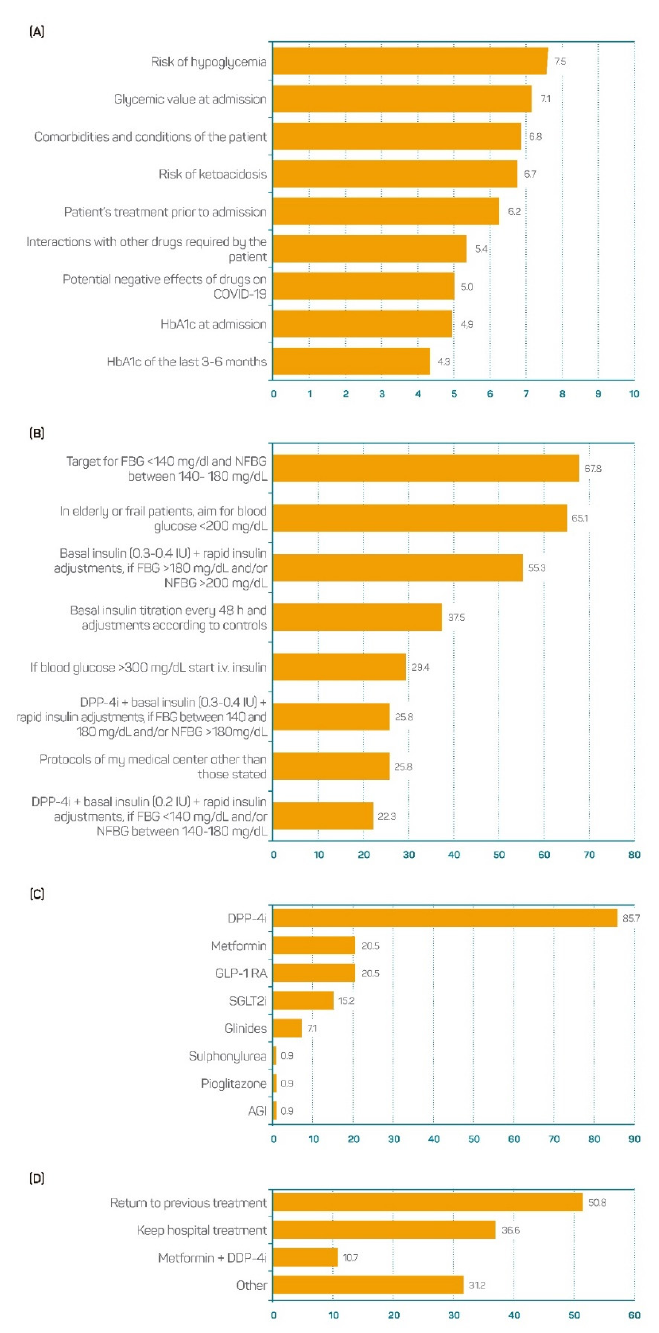
Figure 4. Opinion on clinical practice in patients with known T2DM admitted to hospital due to COVID-19: ( A ) factors to consider when choosing a glucose-lowering treatment; ( B ) criteria to consider when treating hyperglycemia; ( C ) pharmacological class maintained during hospitalization; ( D ) glucose-lowering approach taken at discharge ( n = 112). AGI: Alpha-glucosidase inhibitors; DPP-4i, Dipeptidyl peptidase 4 inhibitors; FBG, fasting blood glucose; GLP-1 RA, Glucagon-like peptide 1 receptor agonists; HbA1c, Glycated haemoglobin; IU, International units; NFBG, non-fasting blood glucose: SGLT2i, Sodium-glucose transport protein 2 inhibitors.